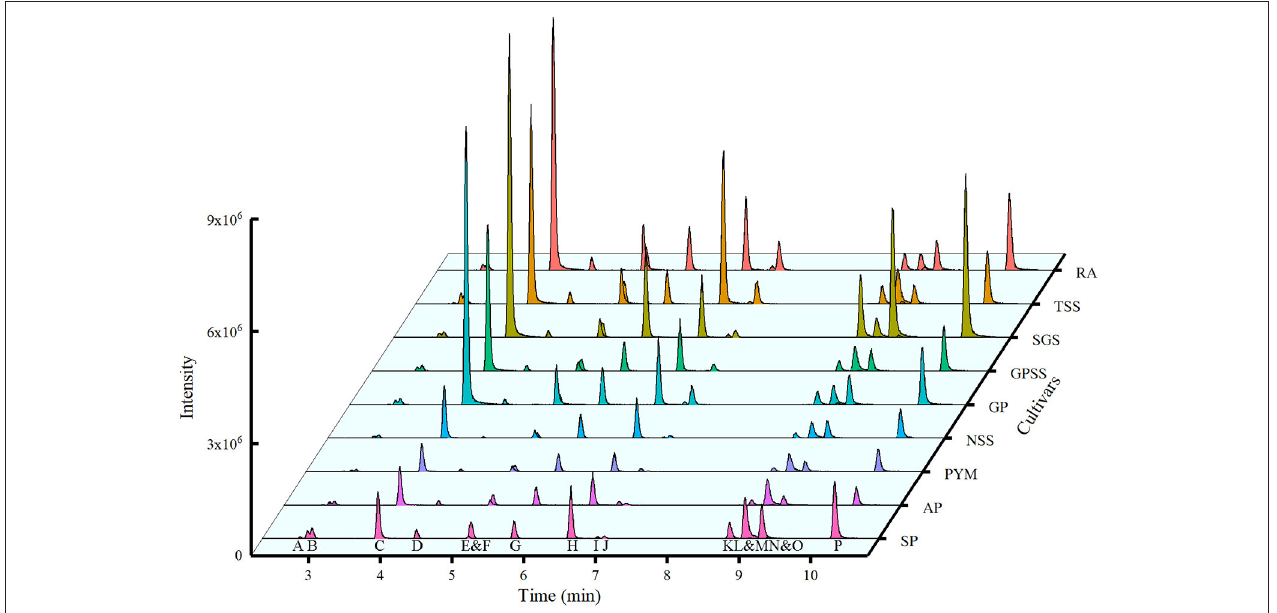
FIGURE 4 | Waterfall chromatogram of ions for quantification from nine cultivars. RA, Red Agate; TSS, Tunisian Soft Seed; SGS, Sweet with Green Seed; GPSS, Green Peel Soft Seed; GP, Green Peel; NSS, Net Skin Sweet; PYM, Piyaman; AP, Acidic Pomegranate; SP, Sweet Pomegranate. The capital letters under the peaks represented the extracted ion chromatography for quantification of the compounds. The name of the compound was A, gallic acid; B, punicalin; C, gallocatechin; D, α -punicalagin; E, epigallocatechin; F, β -punicalagin; G, catechin; H, corilagin; I, epicatechin; J, epigallocatechin gallate; K, rutin; L, ellagic acid; M, epicatechin gallate; N, isoquercitrin; O, luteolin-7-O-glucoside; P,